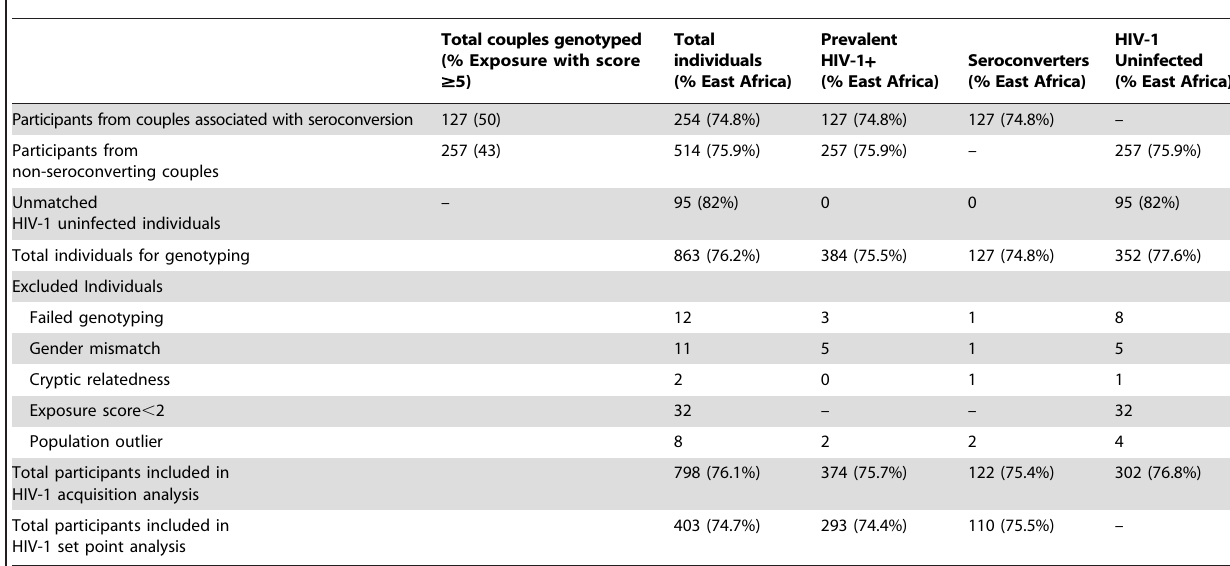
Table 2. Summary of Sample Selection for